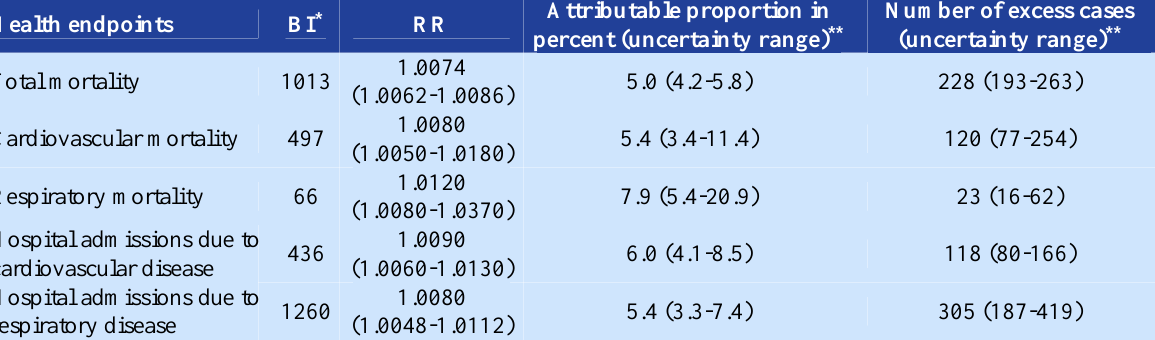
Figure 3. Percentage of days on which people in Sanandaj are exposed to different concentrations of particulate matter with aerodynamic diameters <10 µm Table 1. Baseline incidence, relative risk, estimated attributable proportion, and number of annual excess cases due to short-term exposure to particulate matter with aerodynamic diameters <10 µm above 10 µg/m